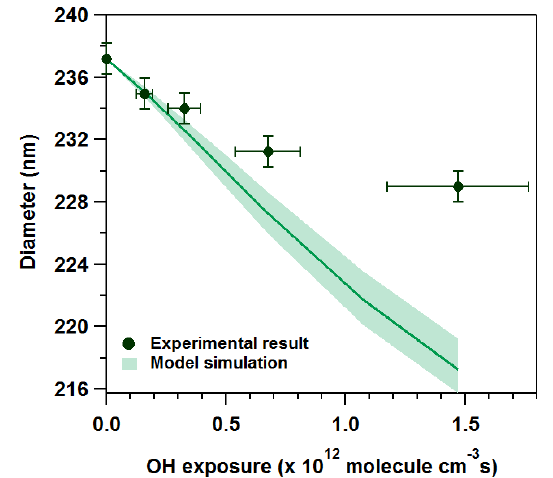
Figure 8. Simulated and experimental result of aerosol diameter during heterogeneous OH oxidation of the aqueous methylsuccinic acid droplet. The shaded region shows the error of the effective OH uptake coefficient ( γ eff ) measurement in the model